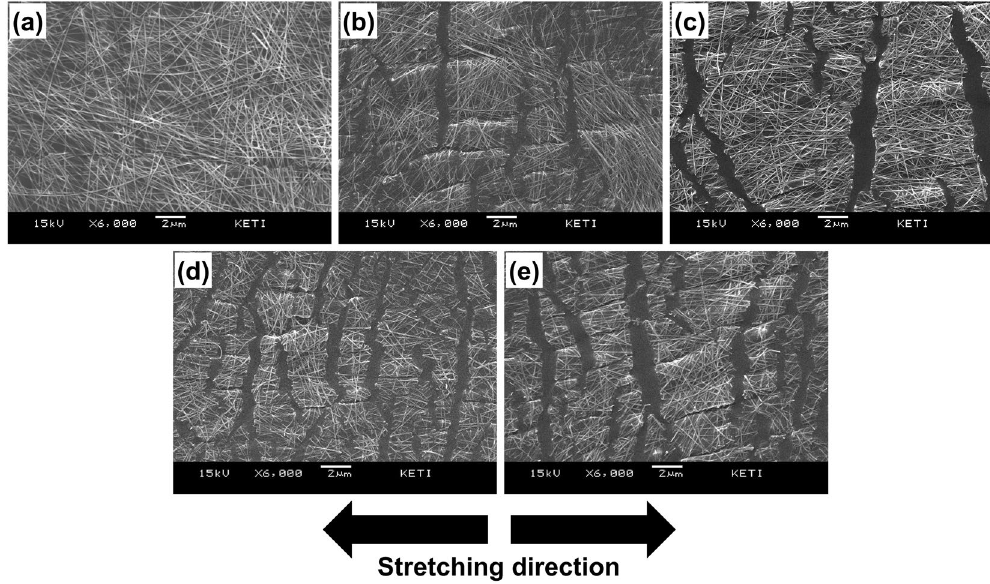
Figure 2. SEM micrographs of AgNWs deposited on hydroxylated PDMS: ( a ) the pristine state, ( b ) the 25% strain stretched state, ( c ) the 50% strain stretched state, ( d ) the 75% strain stretched state, and ( e ) shows an image during stretching at 100%